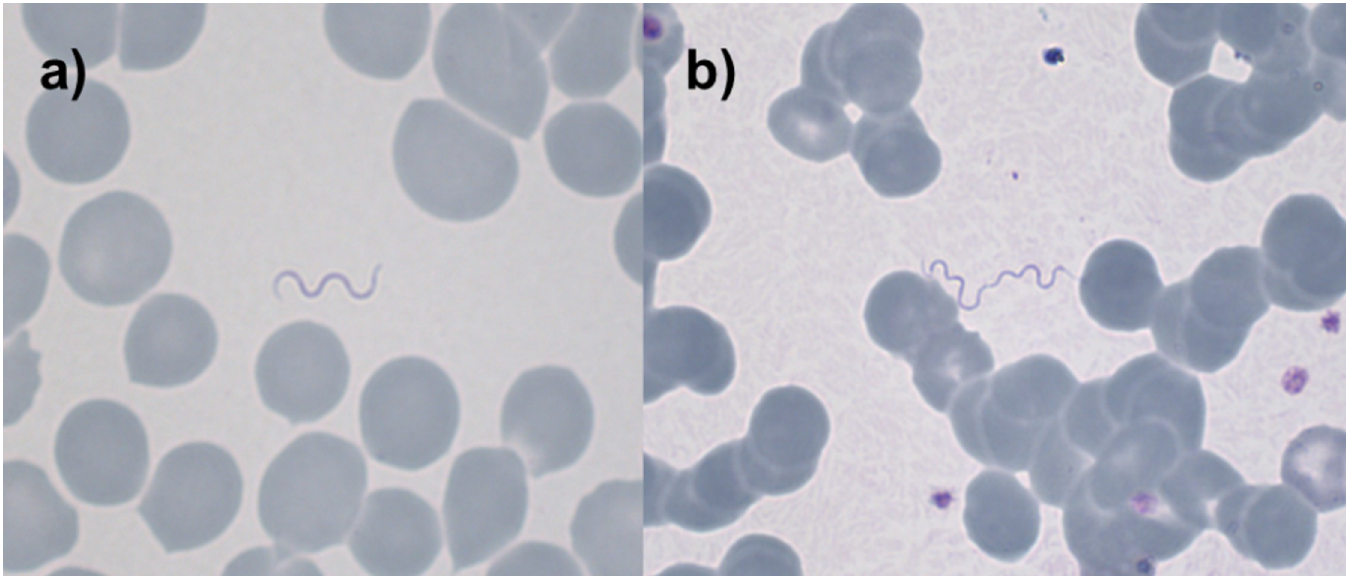
Fig 2. Microscopical detection of TBRF Borrelia in blood films. Microscopic images of Giemsa-stained thin blood films (original magnifications × 1’000) showing TBRF Borrelia in a patient suffering from TBRF fever due to Borrelia persica (courtesy of Dr. Veronika Muigg).